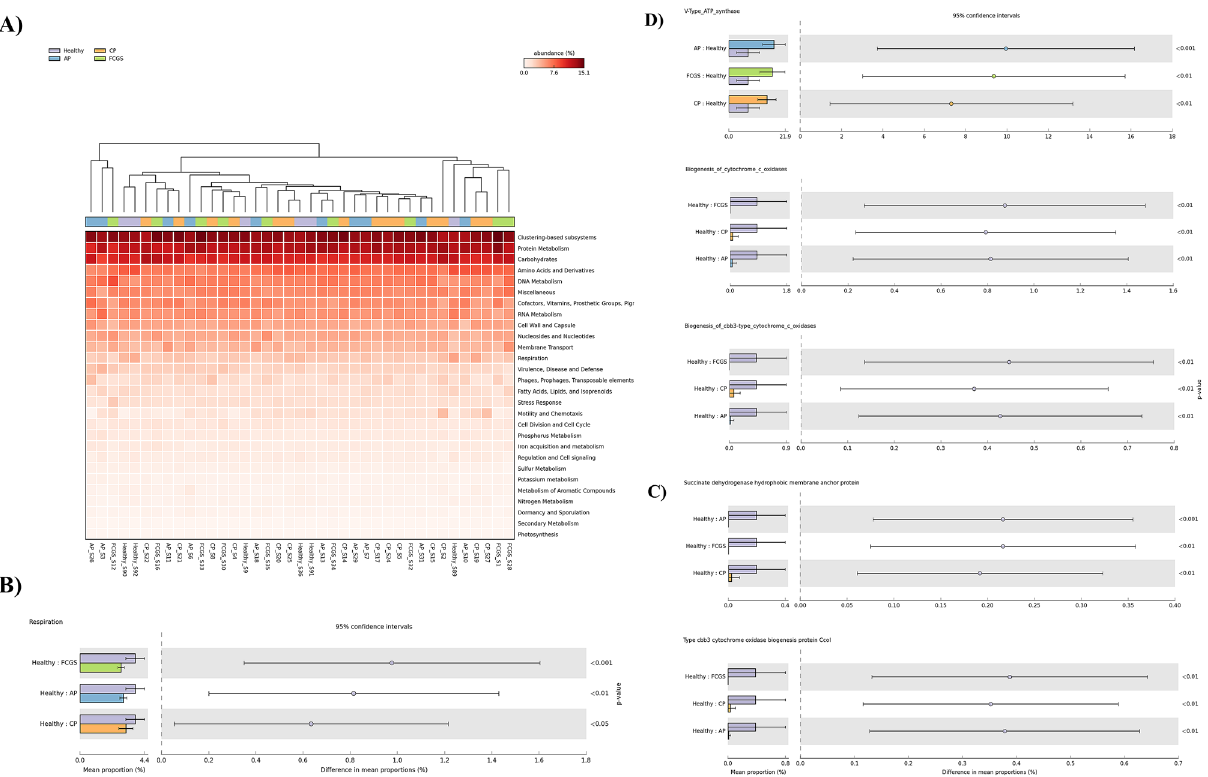
Figure 4. Distribution of functional annotations by SEED Subsystems of subgingival metagenomic data of healthy cats (H) and cats diagnosed with aggressive periodontitis (AP), chronic periodontitis (CP) and feline chronic gingivostomatitis (FCGS). ( A ) Heatmap dendrogram in which features at level 1 were ranked by abundance and metagenomic samples grouped by similarity (unweighted pair group method with arithmetic mean, UPGMA). ( B ) Extended error bar plot showing abundance of predicted functional category, level 1, with significant statistical difference between healthy and diseased cats. ( C ) Extended bar plot illustrating the mean proportion of predict functional features at level 3. ( D ) Extended bar plot showing the mean proportion of predict functional features at function level. The results were filtered using a P -value of 0.05 according to ANOVA and Tukey–Kramer with Benjamin-Hochberg FDR correction ( P -value < 0.05). All graphs were generated using STAMP v2.1.3 (Statistical Analysis of Metagenomic Profiles) software (https:// beiko lab. cs. dal. ca/ softw are/